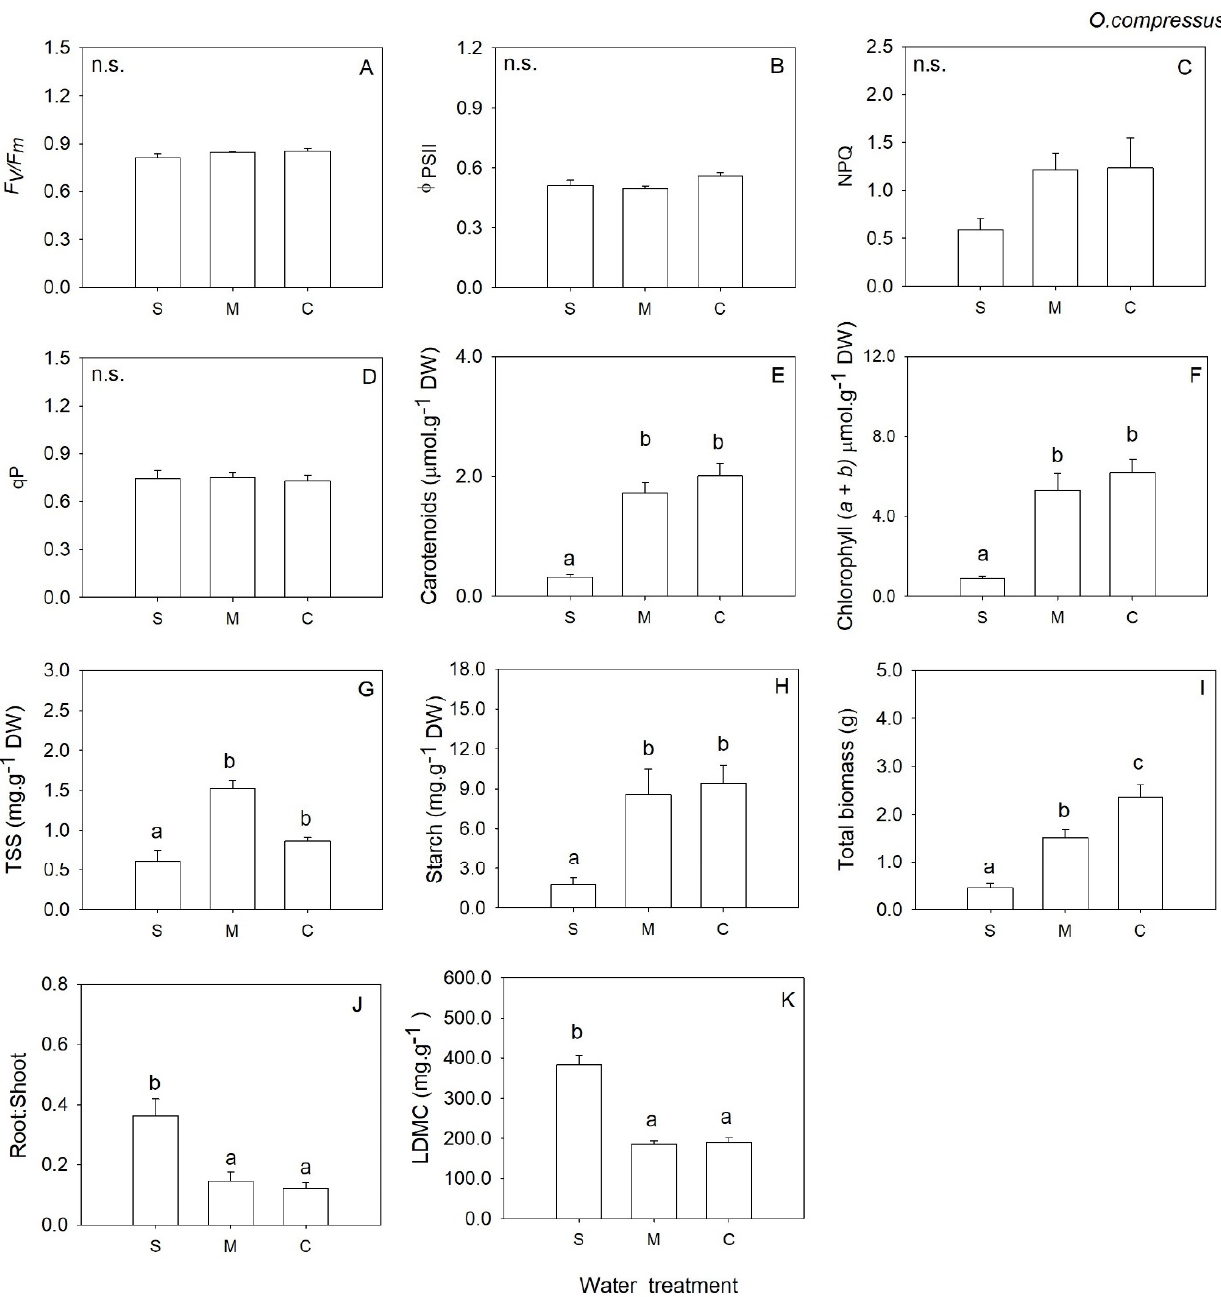
Figure 3. Mean values (+SE) of maximum quantum efficiency of photosystem II ( A ), the effective quantum efficiency of PSII ( B ), non-photochemical quenching ( C ), photochemical quenching ( D ), carotenoids content ( E ), chlorophylls ( a + b ) ( F ), total soluble sugars ( G ), starch content ( H ), total biomass ( I ), root to shoot biomass ratio ( J ) and Leaf Dry Matter Content ( K ) Ornithopus compressus grown under severe water deficit (S), moderate water deficit (M) and control (C) conditions. Significant differences at p < 0.05 among treatments are indicated by different letters. n.s., not significant.